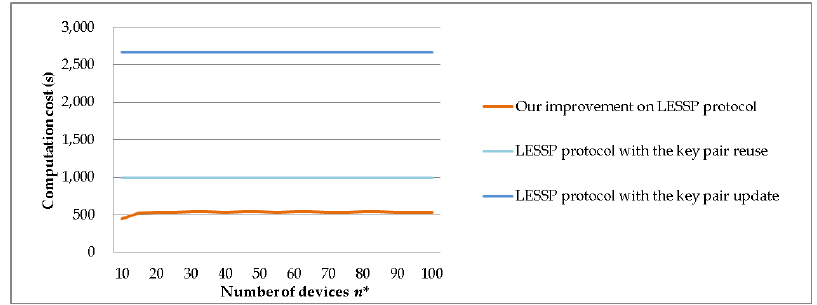
Figure 13. The computation time costs against the number of devices n *.